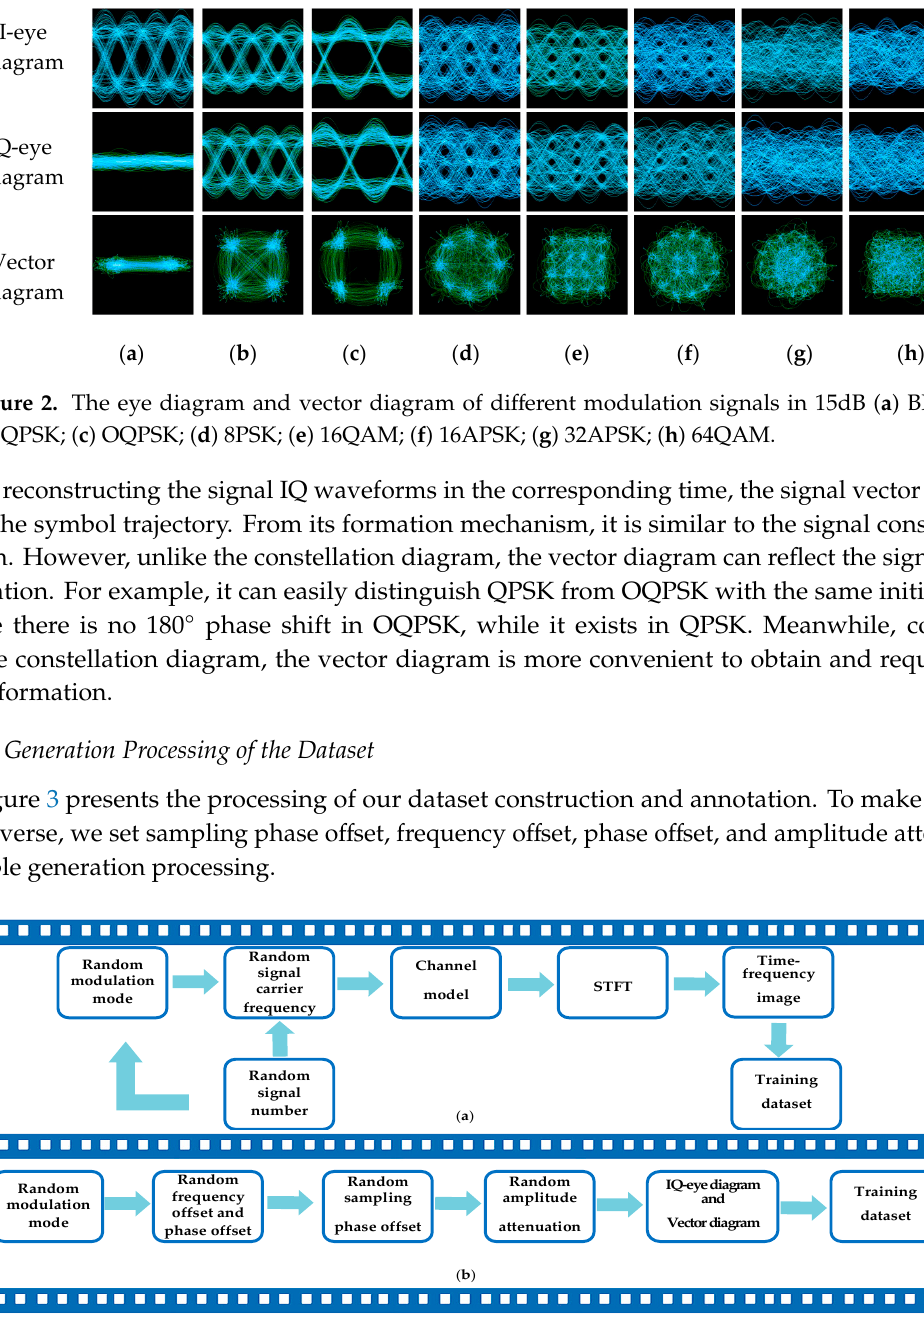
Figure 1. Different modulation signals in the wideband.